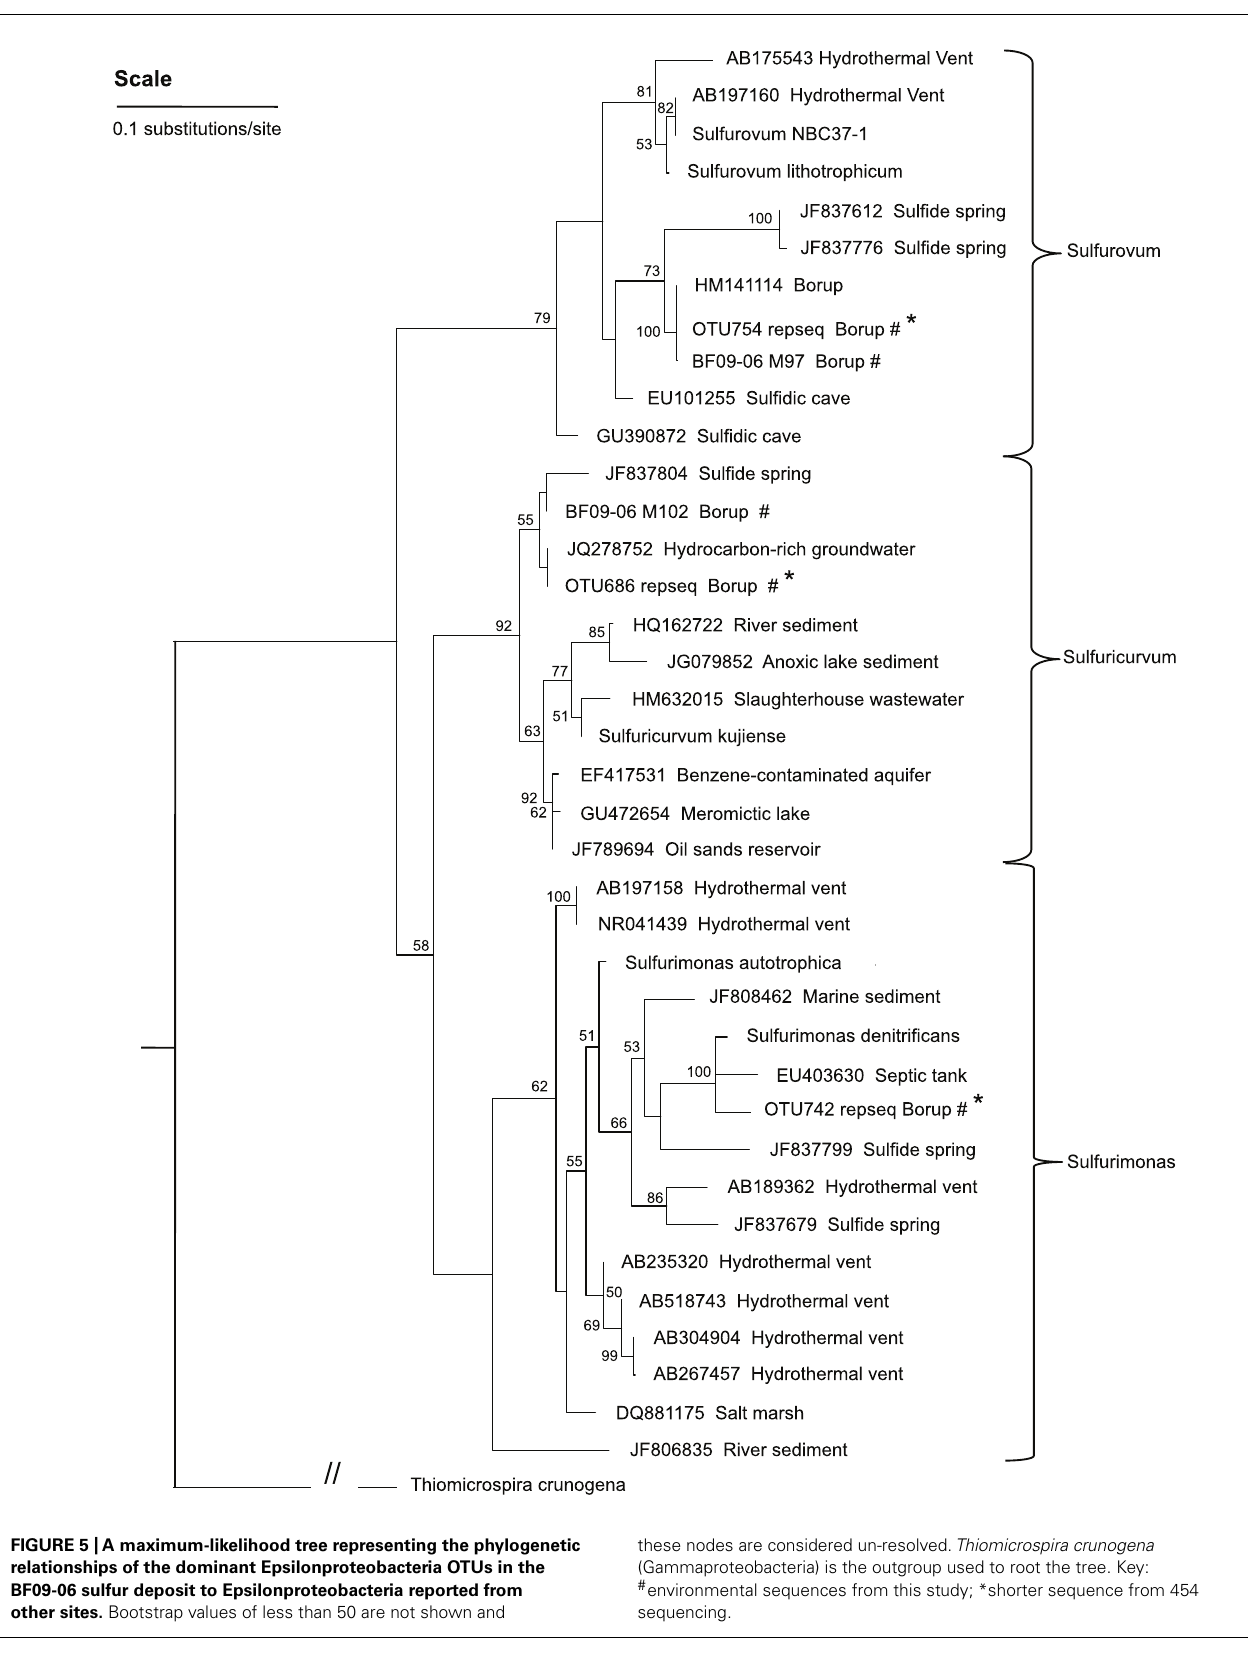
these nodes are considered un-resolved. Thiomicrospira crunogena (Gammaproteobacteria) is the outgroup used to root the tree. Key: # environmental sequences from this study; *shorter sequence from 454